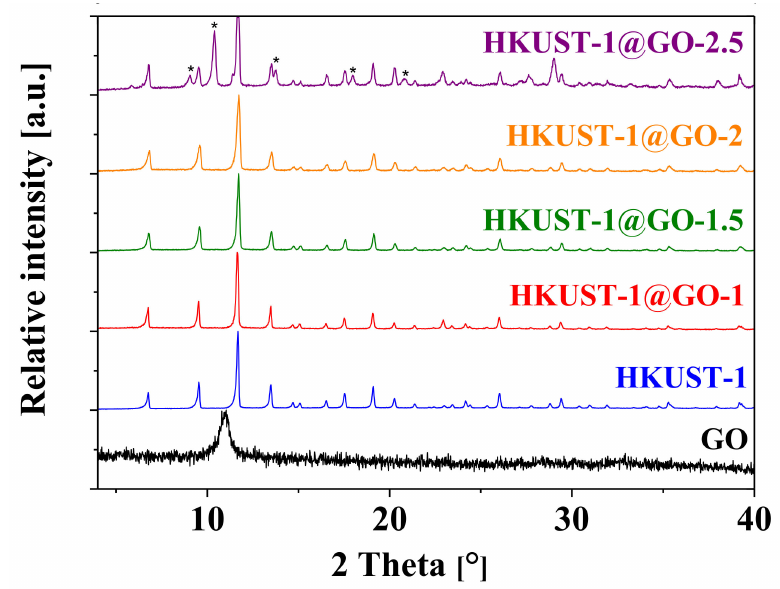
Figure 3. X-ray di ff raction (XRD) patterns of the pristine GO, HKUST-1 and the composite materials with di ff erent GO contents. The peaks were normalized to the maximum intensity peak and shifted for better visibility. * marks unidentified peaks not belonging to